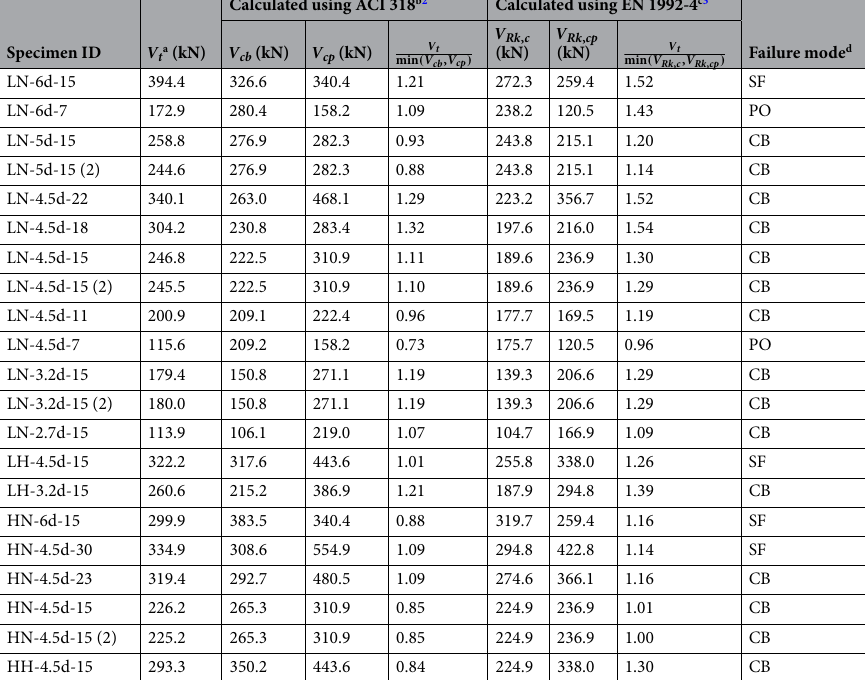
Table 3. Comparison of test results and strength by ACI 318 and EN1992-4. a Measured failure load. b Calculated on the basis of ACI 318, V cb is the concrete breakout strength, V cp is the concrete pryout strength. c Calculated on the basis of EN 1992-4, V Rk , c is the concrete breakout strength, V Rk , c is the concretepryout strength. d SF Steel failure of anchor bolt, PO pryout failure, CB concrete breakout failure.